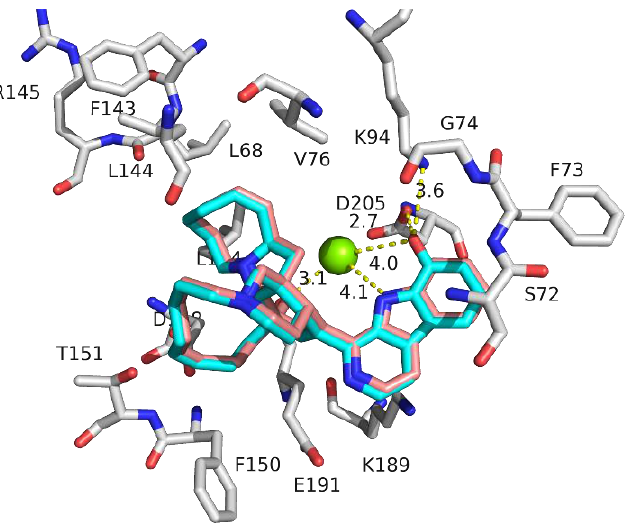
Figure 3. Three-dimensional representation of the docking pose of manzamine A (2, salmon) and 8-Hydroxymanzamine A (3, blue) within the active site of RSK1 N-terminal kinase domain (NTKD). Hydrogen bonds and interactions with Mg +2 for the β –carboline part of the molecule are shown as yellow–dotted lines. Hydrophobic interacting residues are shown and form a hydrophobic pocket in the active site.